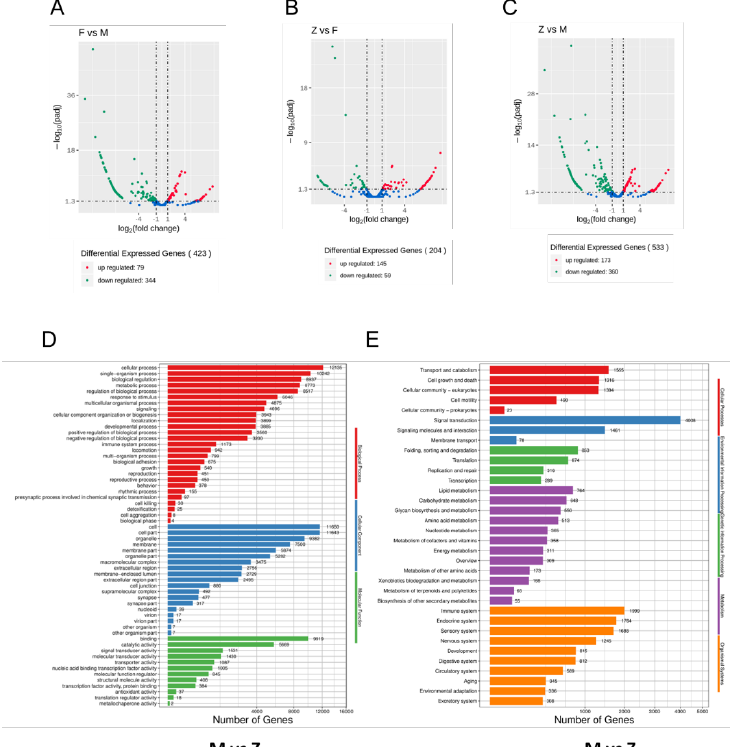
Figure 4. Differential miRNAs analysis of males, females, and pseudo-females (F, M and Z): ( A ) The differential expressed miRNAs between female and male individuals. ( B ) The differential expressed miRNAs between female and pseudo-female individuals. ( C ) The differential expressed miRNAs between male and pseudo-female individuals. ( D ) GO enrichment analysis of target genes of differential miRNAs between male and pseudo-female individuals. ( E ) KEGG enrichment analysis of target genes of differential miRNAs between male and pseudo-female